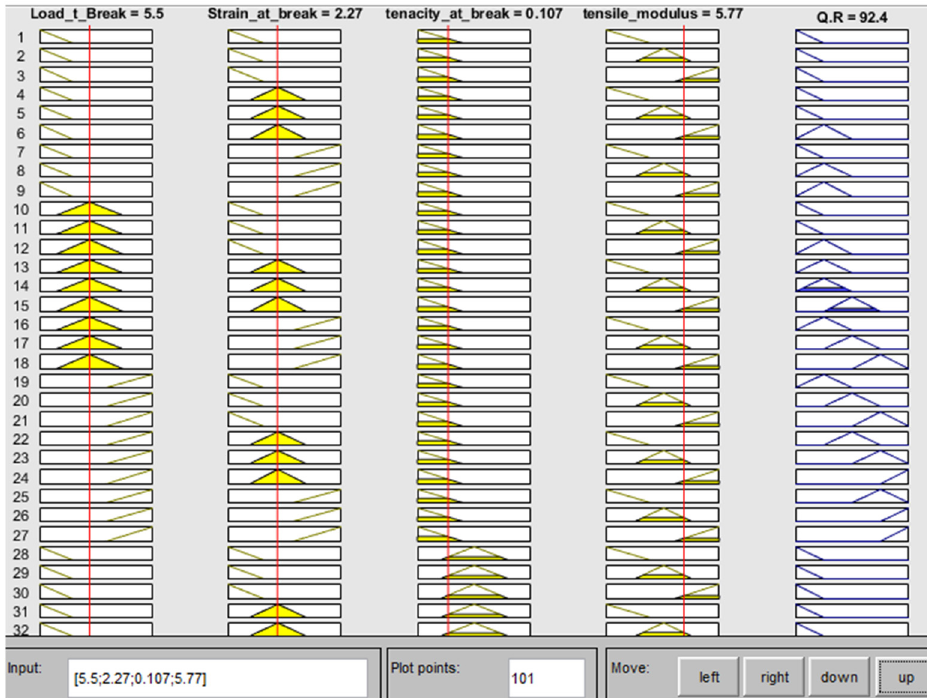
Figure 6. MATLAB rule viewer of quality ratio.